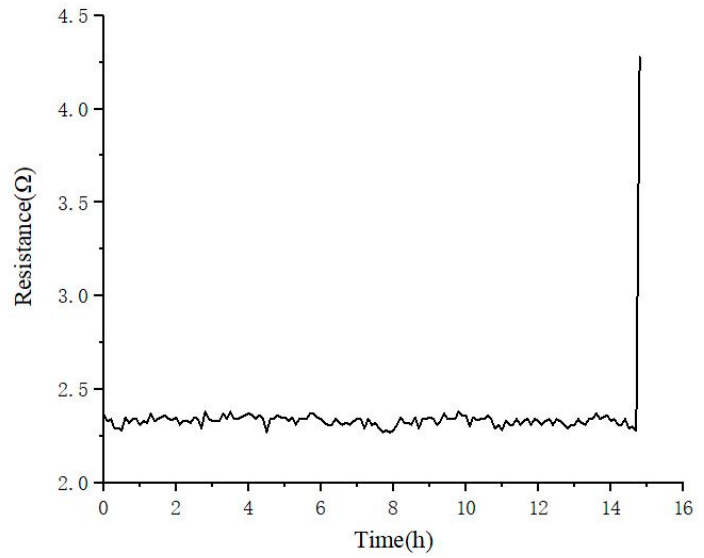
Figure 16. The resistance of daisy chain circuit specimen 29B as the function of time for the random vibration tests.